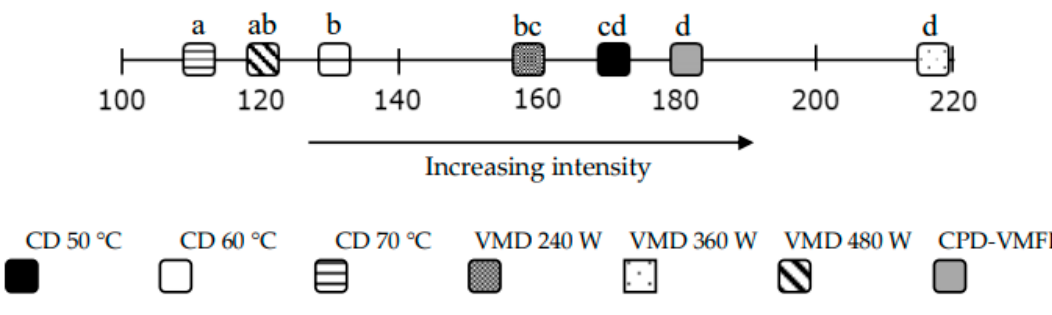
Figure 2. Rank sum scale of lavender aroma intensity. Friedman’s test by Honest Significance Difference (HSD) test ( α ); different letters after each dried sample indicate a significant difference at p < 0.05.